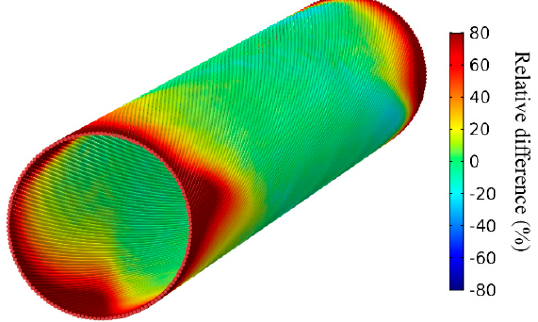
Figure 3. Relative difference in the armor losses between periodic and non ‐ periodic 3D FEM models.